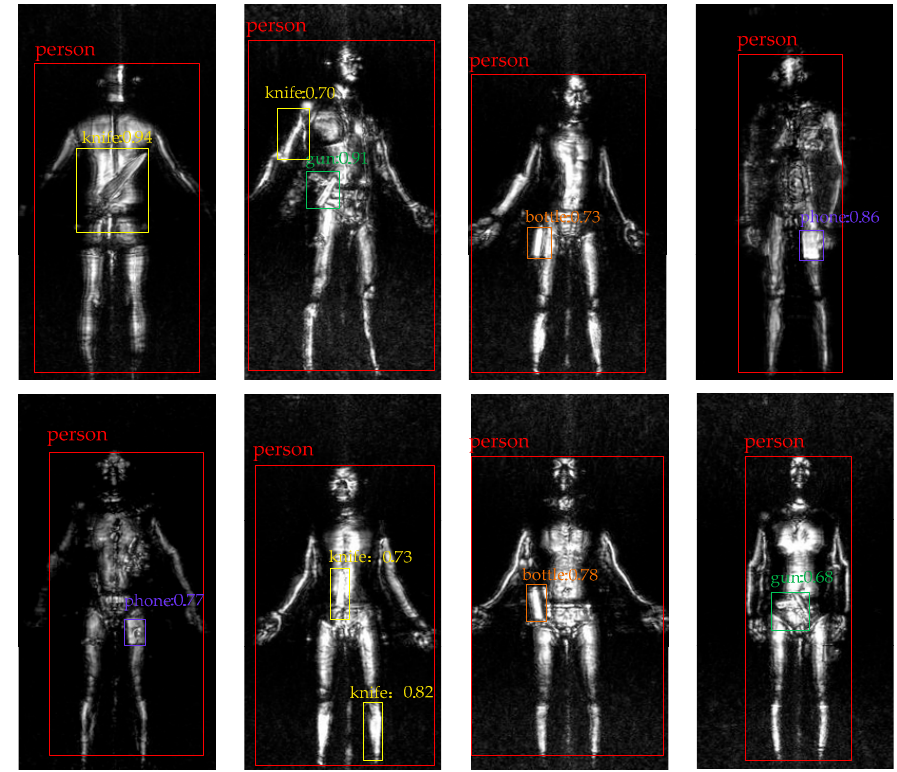
Figure 10. Selected detection results with IFRCNN on terahertz image dataset.